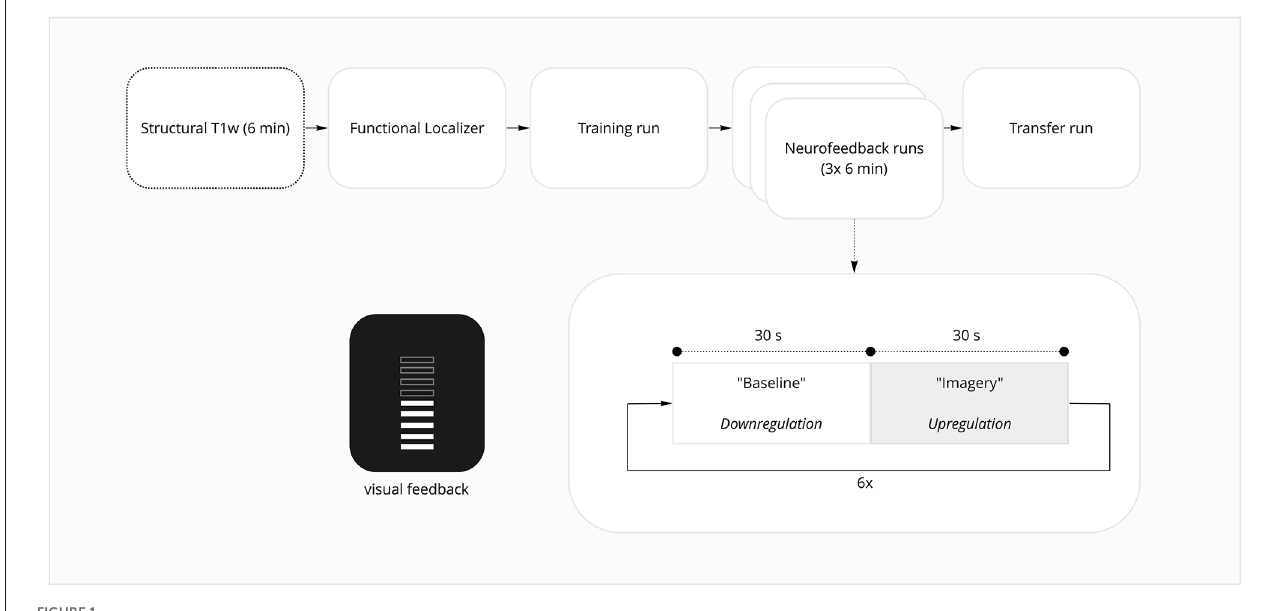
FIGURE1 fMRI session